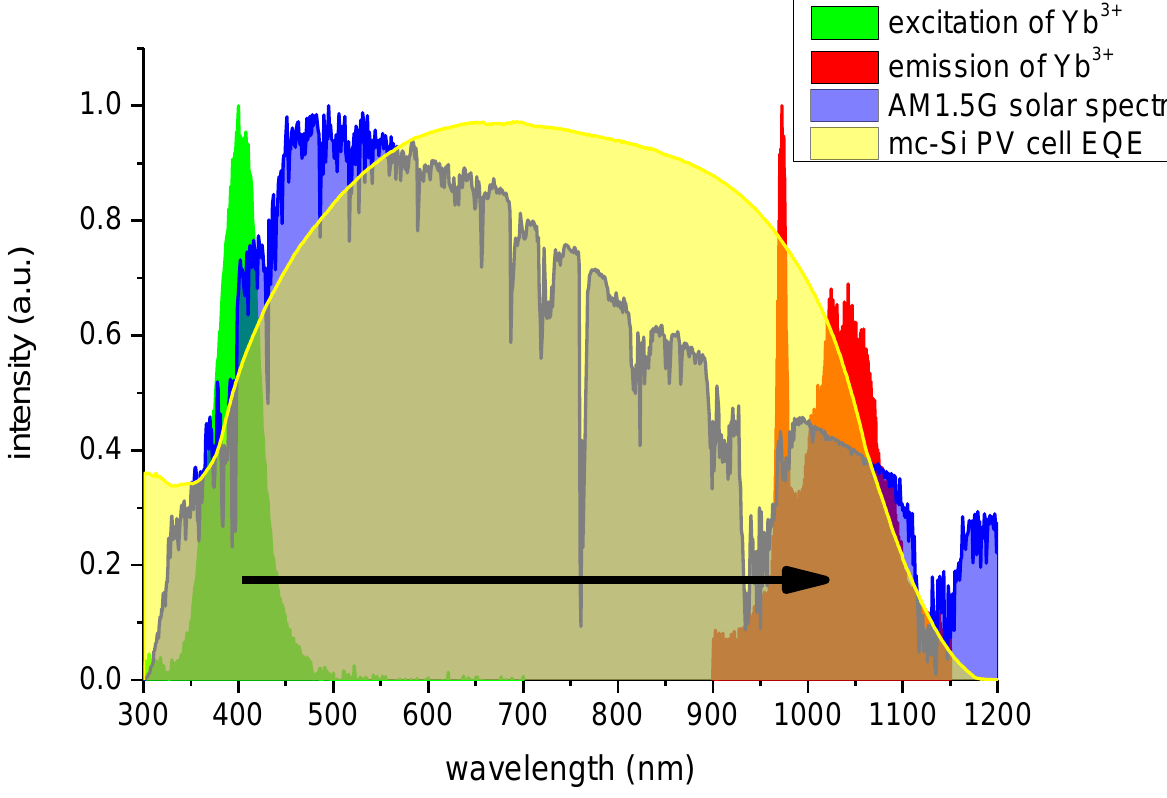
Figure 10. Excitation and emission bands of YAM: Ce 3+ + Yb 3+ phosphors overlaid on AM1.5G solar spectrum and EQE of a typical crystalline solar cell.